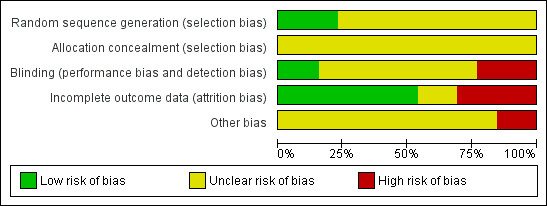
Risk of bias graph.